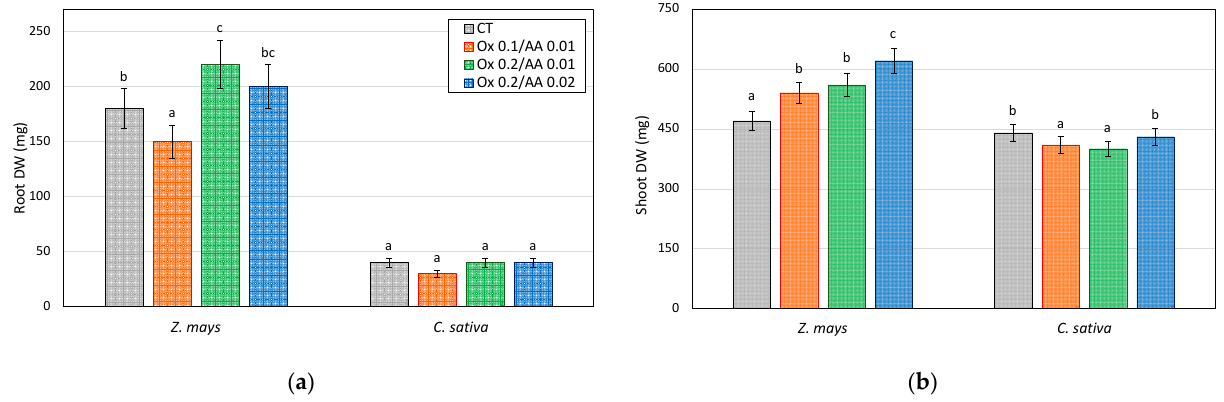
CT Ox 0.1/AA 0.01 Ox 0.2/AA 0.01